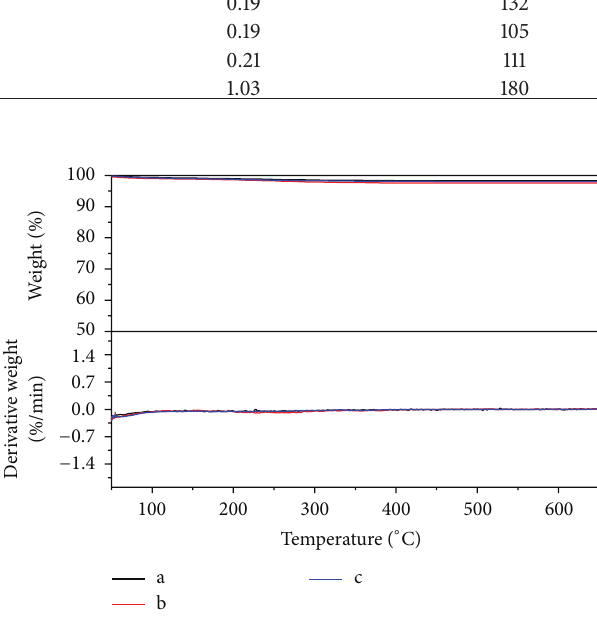
Figure 3: TGA-DTA of synthesized TiO 2 nanoparticles using an activated carbon template in different quantities and with calcina- tion at 500 ∘ C for 3 hr: (a) 0%, (b) 5%, and (c) 10%.